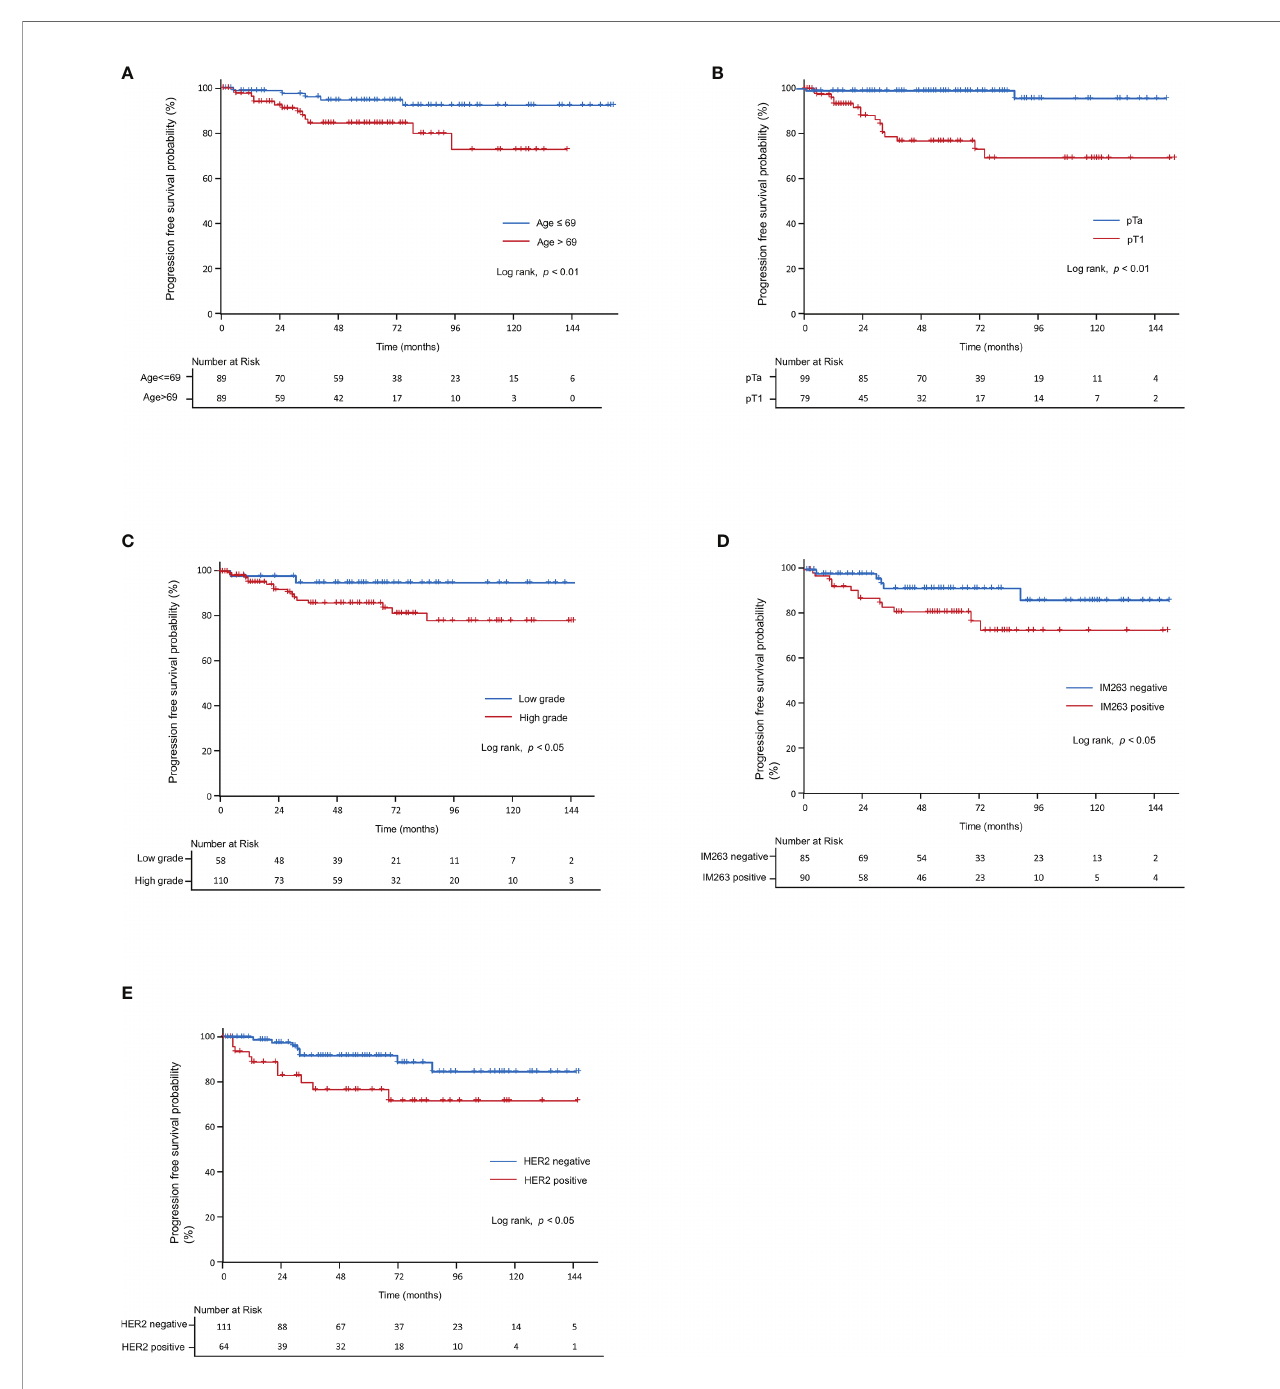
FIGURE 6 | Kaplan – Meier curve for progression-free survival in non-muscle-invasive bladder cancer patients. Progression-free survival according to (A) age, (B) T-stage, (C) grade, (D) IM263, and (E) HER2+. HER2, human epidermal growth factor